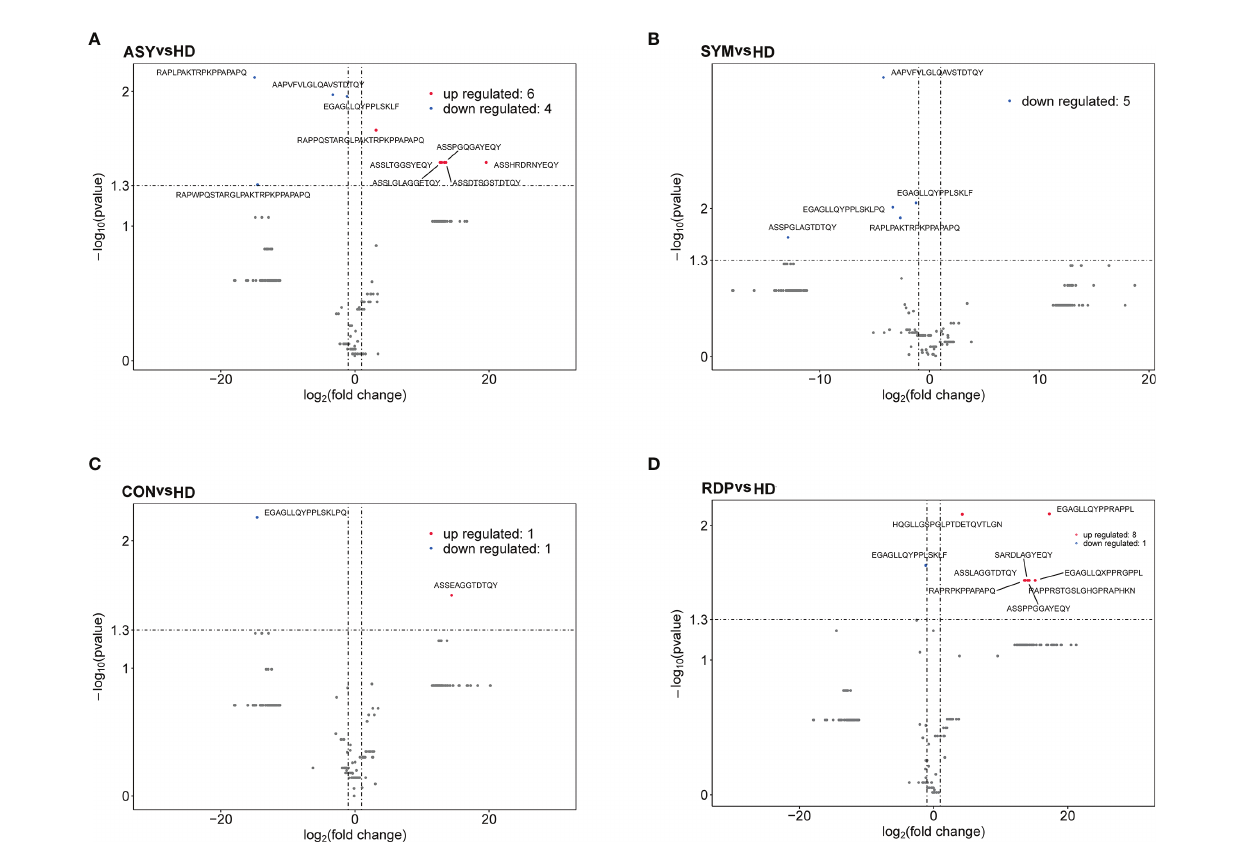
FIGURE 3 | Volcano plots showing differential expression (i.e., |log2(FC)| > 1, p < 0.05) of amino acid clonotypes between patients and healthy donors. (A) ASY vs. HD. (B) SYM vs. HD. (C) CON vs. HD. (D) RDP vs. HD.